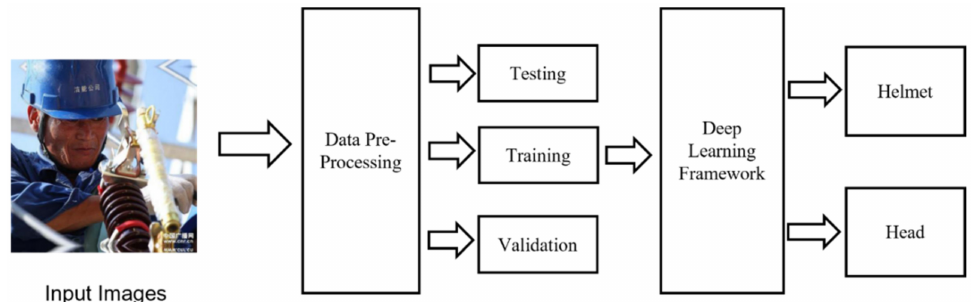
Figure 2. General Architecture for Worker Safety Helmet Detection using Deep Learning